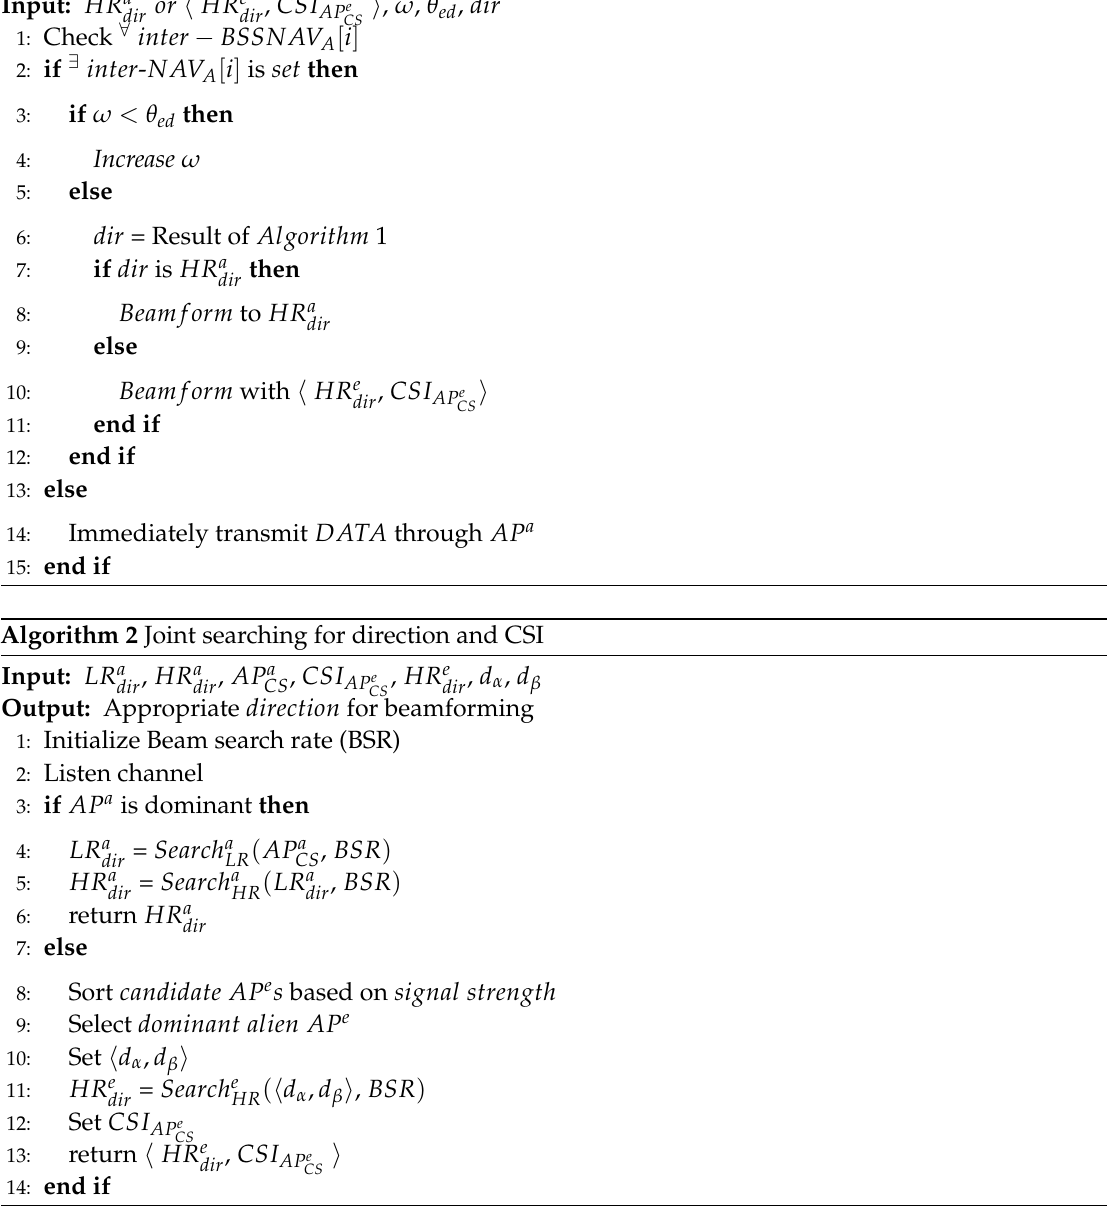
Algorithm 1 Proposed beamforming algorithm